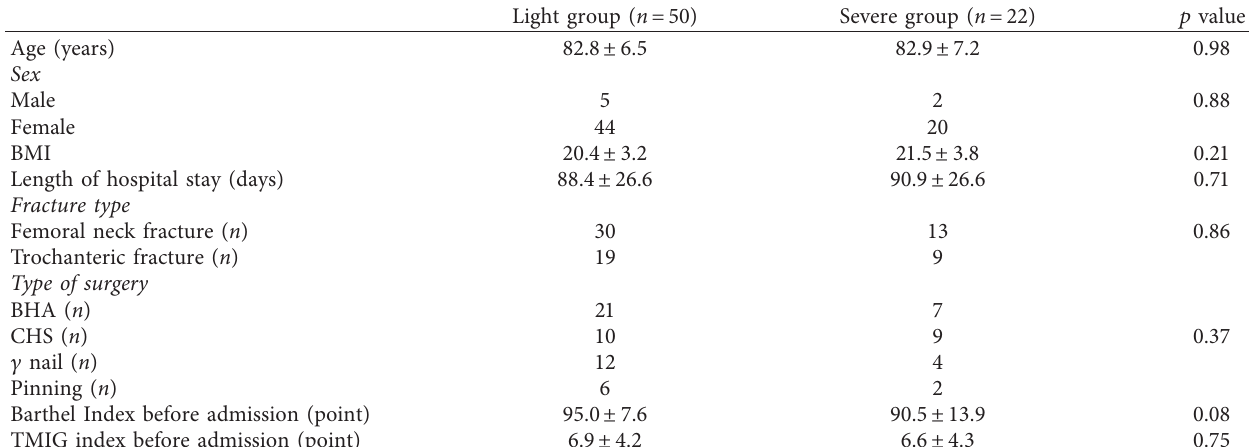
Table 1: Patient characteristics.